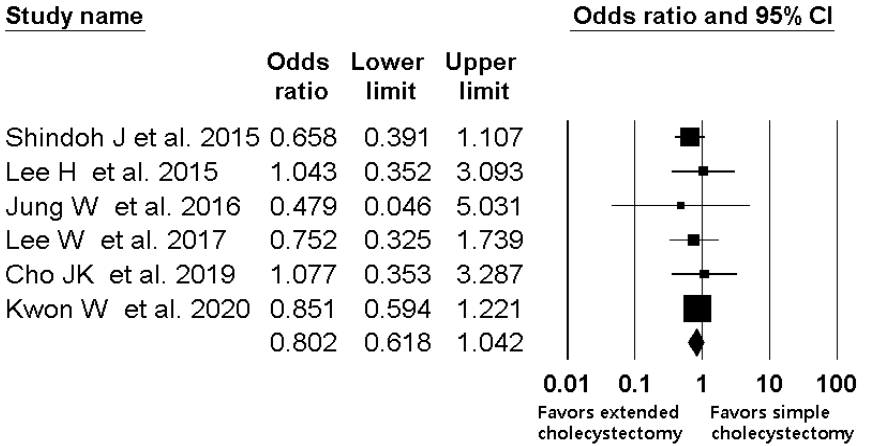
Figure 3. Forest plot of overall survival between extended cholecystectomy and simple cholecystectomy in T2a GBC patients. The figure depicts individual trials as filled squares with relative sample size and the 95% confidence interval (CI) of the difference as a solid line. The diamond shape indicates the pooled estimate and uncertainty for the combined effect.